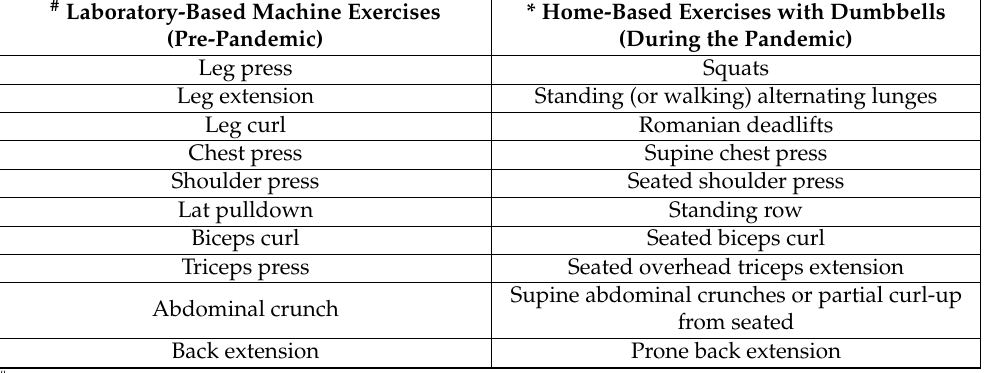
Table 1. Comparison of resistance training program before and during the COVID-19